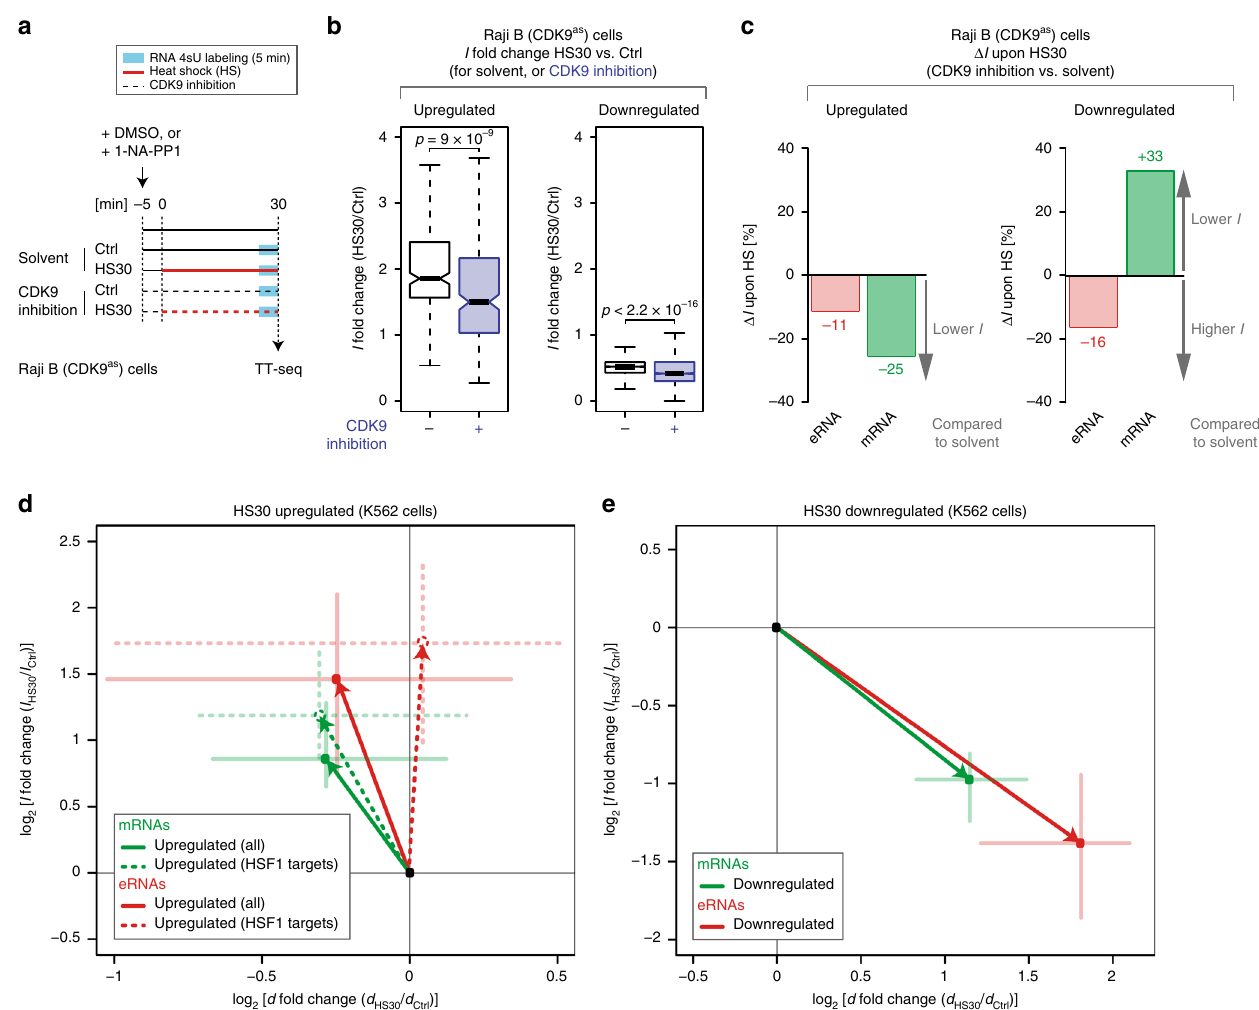
Fig. 4 Enhancer transcription is generally not pause limited and less dependent on CDK9. a Experimental setup. The adenine analog 1-NA-PP1 allows for rapid and highly speci fi c inhibition of analog-sensitive CDK9 82 in CRISPR-Cas9 engineered human Raji B (CDK9 as ) cells 28 (Supplementary Fig. 8b – d). CDK9 was inhibited using 5- µ M 1-NA-PP1 (CDK9 inhibition) in combination with heat shock at 42 °C for 30 min in human Raji B (CDK9 as ) cells. DMSO was used as solvent control. b Boxplots of productive initiation frequency I fold change before (in white) and after CDK9 kinase inhibition (in dark blue). Shown are 241 signi fi cantly upregulated genes (left boxplot), and 2795 signi fi cantly downregulated genes (right boxplot) annotated in Raji B (CDK9 as ) cells (Supplementary Fig. 9). c Δ I upon upregulation or downregulation between heat shock with CDK9 inhibition (CDK9 inhibited HS30) and heat shock with solvent control (Solvent HS30) is shown in percent [%]. Left: bar plot comparing productive initiation frequency I change ( Δ I ) with and without CDK9 inhibition for 92 signi fi cantly upregulated mRNAs (in green), and 54 signi fi cantly upregulated eRNAs (in red) annotated in Raji B (CDK9 as ) cells. Right: bar plot comparing productive initiation frequency I change ( Δ I ) with and without CDK9 inhibition for 2210 signi fi cantly downregulated mRNAs (in green), and 223 signi fi cantly downregulated eRNAs annotated in Raji B (CDK9 as ) cells. d Log2 fold change of pause duration d and initiation frequency I for 336 signi fi cantly upregulated mRNAs (green solid line), and 67 signi fi cantly upregulated eRNAs (red solid line) in K562 cells upon 30 min of heat shock (HS30) (Supplementary Fig. 4a). Dashed lines represent HSF1 driven ( “ Methods ” ) subsets of 91 mRNAs and 20 eRNAs. e Log2 fold change of pause duration d and initiation frequency I for 1101 signi fi cantly downregulated mRNAs (in green), and 99 signi fi cantly downregulated eRNAs (in red) in K562 cells upon 30 min of heat shock (HS30) (Supplementary Fig.